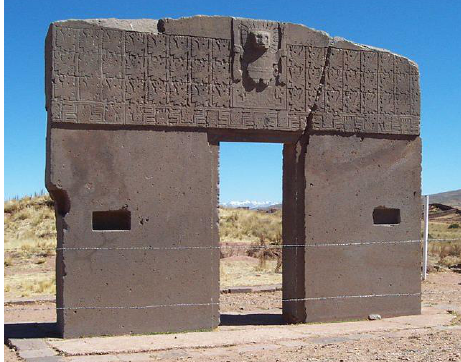
Fig.4 Puerta del Sol (Tiahunaco, uncertain